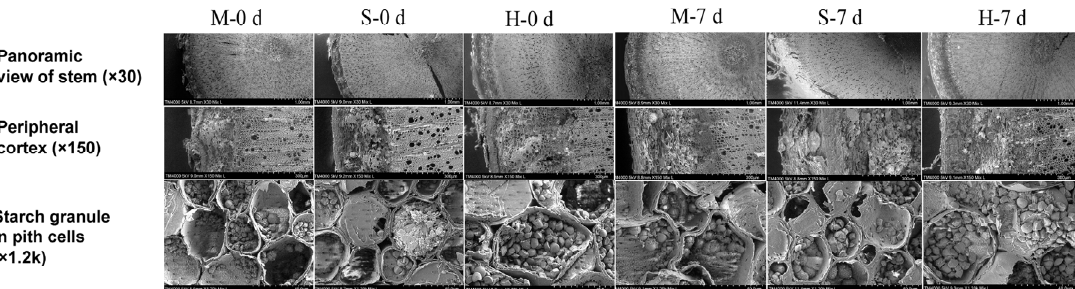
Figure 9. SEM observation and comparison of anatomical structure changes of stem (cross-section) of different peach rootstocks, the biggest differences between the two treatments (un-stressed control and 7 d of waterlogging) are the morphology of the peripheral cortex layer, and the amount of starch granules in the pith cells. Abbreviations: M: Prunus persica, ‘Maotao’; S: Prunus davidiana, ‘Shantao’; H: ‘Hossu’. Stem samples were collected under non-stressed condition (M-0, S-0, H-0) and on the 7th day (M-7, S-7, H-7) of WT. “ × 30”, “ × 150”, and “ × 1.2 k” refer to different magnifications of SEM when observing different parts of